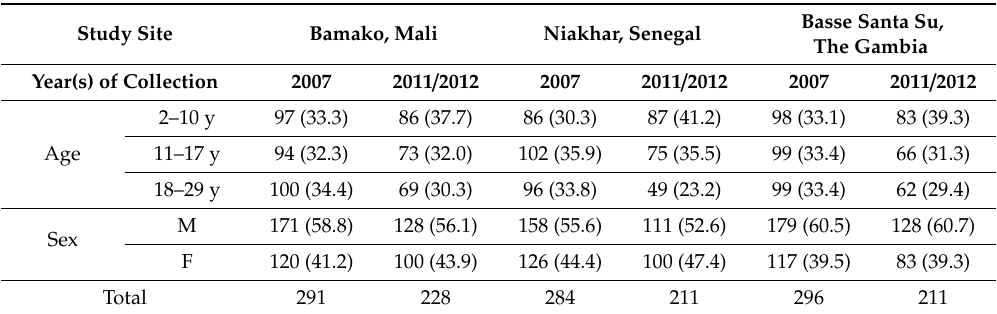
Table 1. Samples collected in Mali, Senegal and The Gambia in 2007 and 2011/2012 by age group and sex (%).